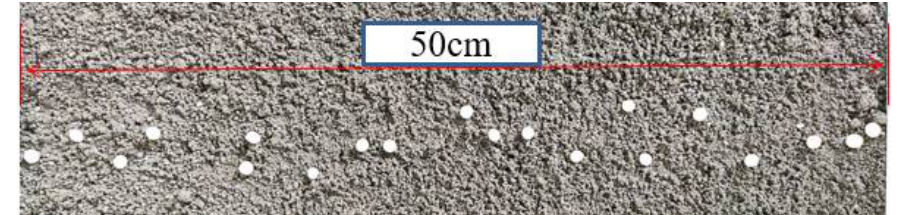
Figure 17. Distribution of soybean seed particles on the soil tray.